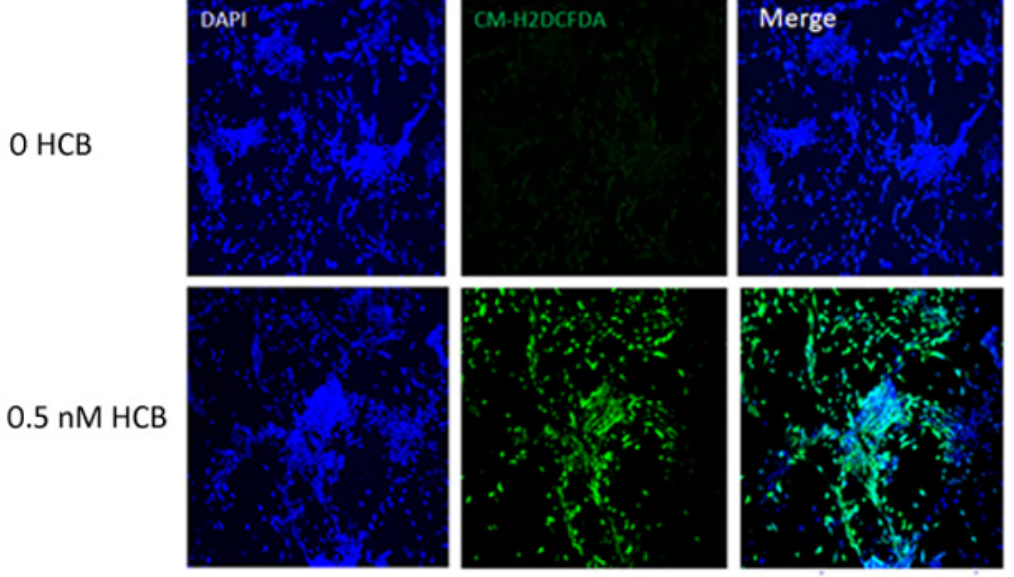
Figure 4. Induction of ROS production by HCB. Encapsulated cells were cultured